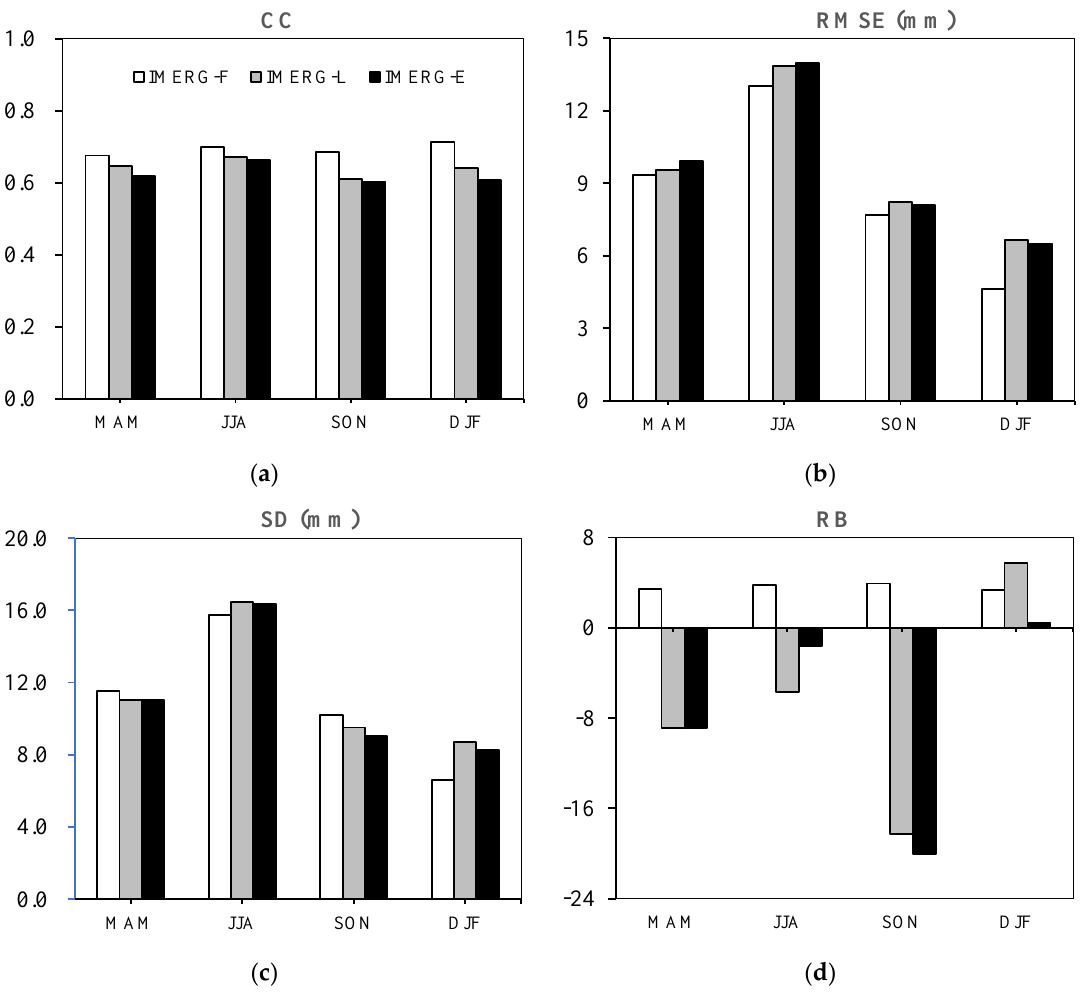
Figure 7. Spatial distribution of correlation coefficient ( a ), root mean square error ( b ), standard deviation ( c ), and relative bias ( d ) between IPPs and gauged observation at a seasonal timescale, with daily data evaluated for the various seasons.